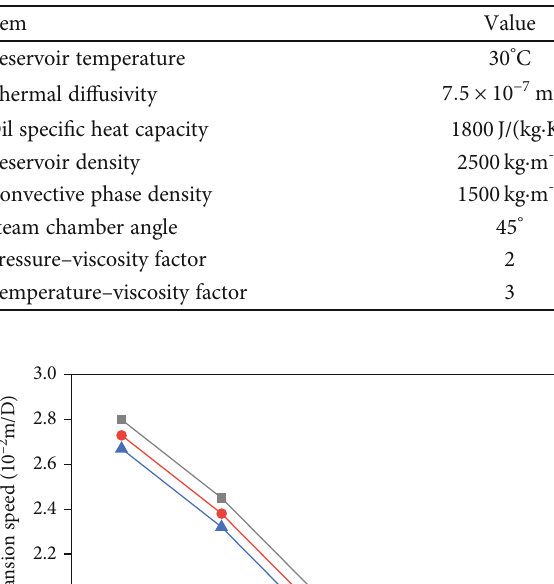
Figure 9: Schematic of the lateral expansion speed of steam cavity under di ff erent reservoir heat